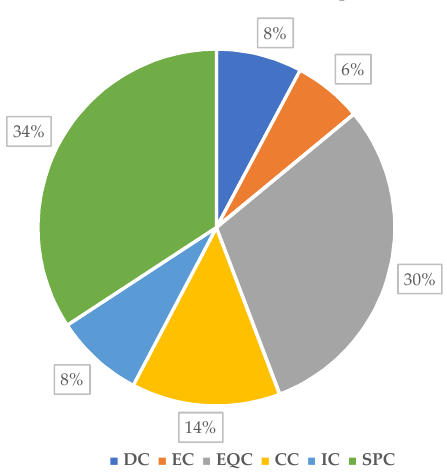
Figure 7. Cost structure of a 100 MW solar PV power station.